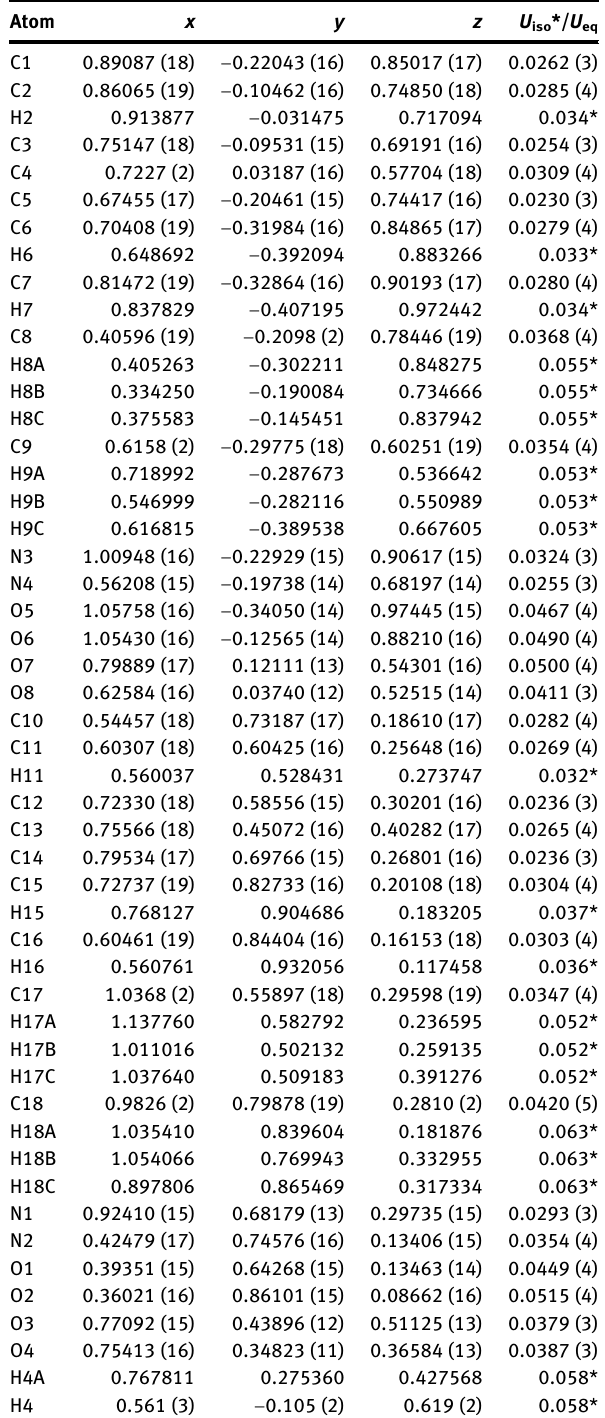
Table  : Fractional atomic coordinates and isotropic or equivalent isotropic displacement parameters (Å 